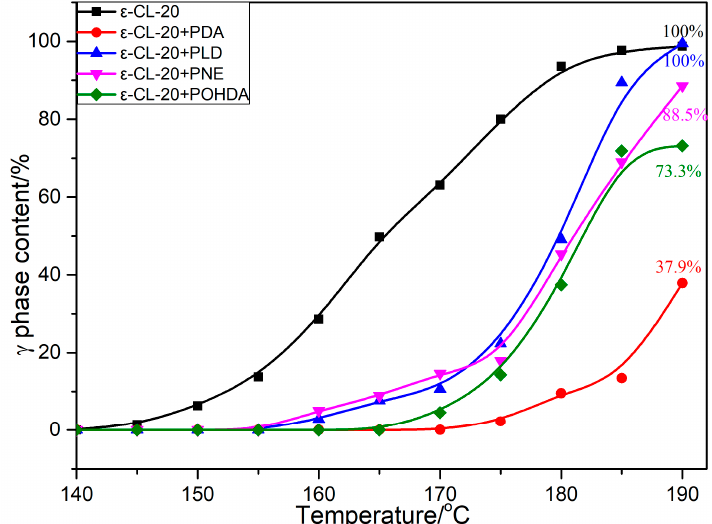
Figure 10. XRD patterns of core-shell composites at various temperatures: ( a ) ε -CL-20 / PDA, ( b ) ε -CL-20 / PLD, ( c ) ε -CL-20 / PNE, and (d) ε -CL-20 / POHDA. Appl. Sci. 2020 , 2 , x FOR PEER REVIEW